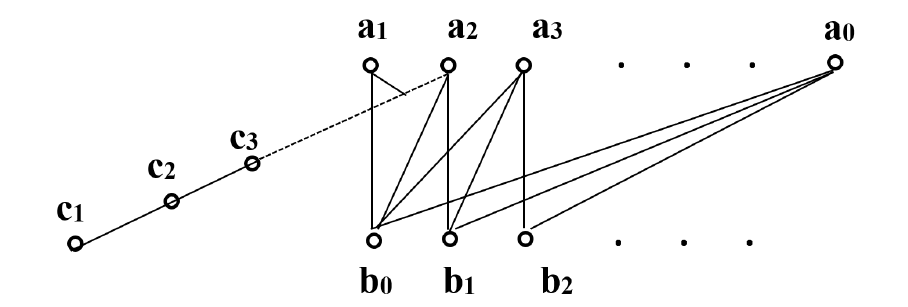
Figure 1: A set which is SI-open is not weakly irreducibly